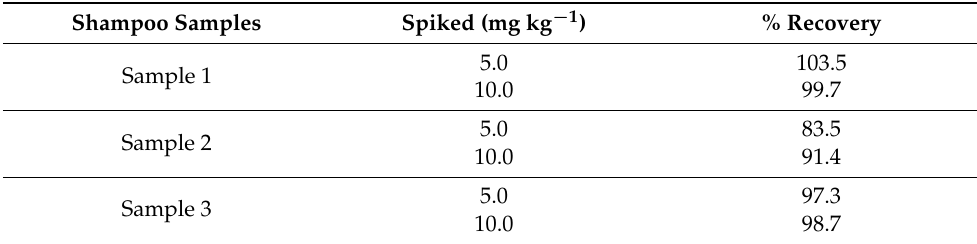
Figure 3. Representative overlaid chromatograms of standard solution (30 mg kg − 1 histidine) and shampoo and conditioner samples using the proposed HPLC-PCD method. Table 4. Accuracy of the proposed method for the analysis of histidine in diluted real samples ( n =